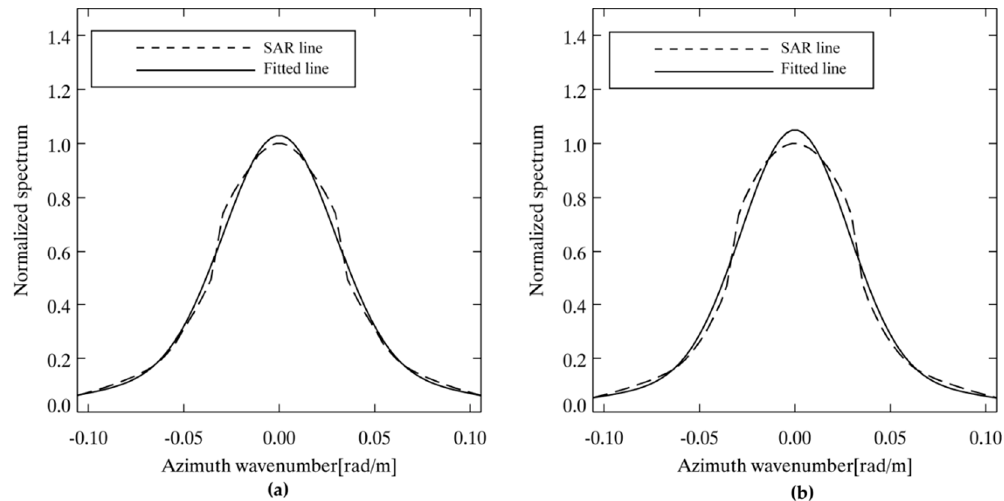
Figure 8. Fitted result with integrated one-dimensional spectra ( a ) corresponding to Figure 3a; and ( b ) corresponding to Figure 3b.